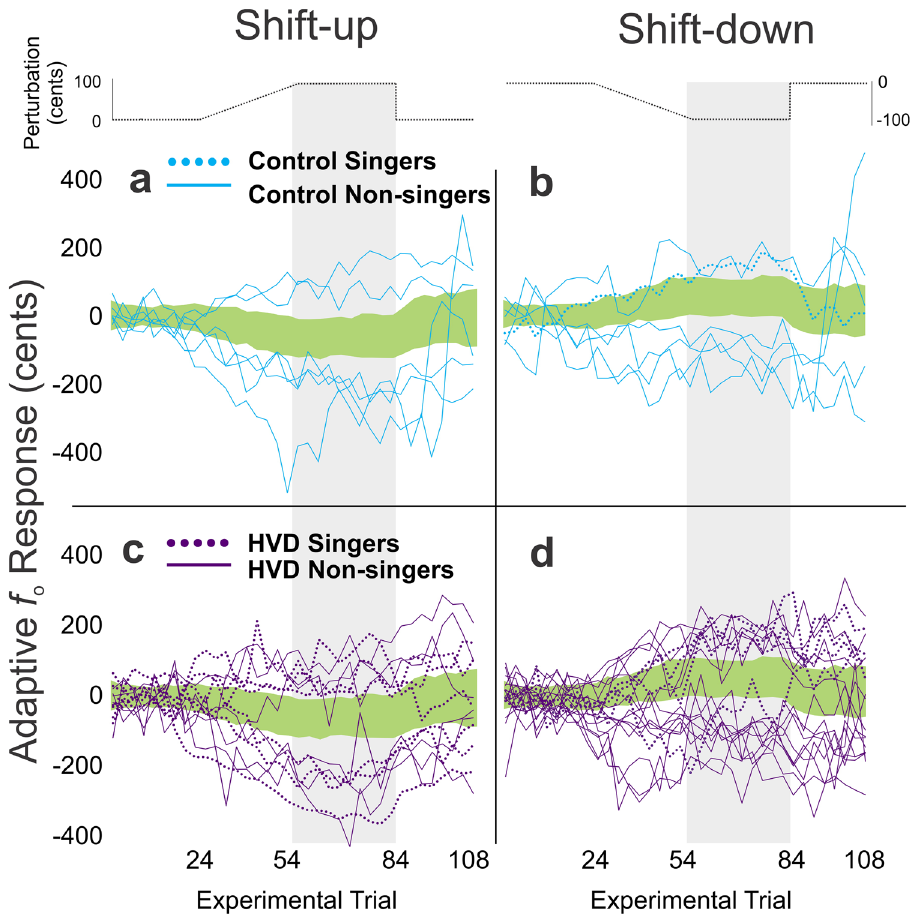
Figure 3. Adaptive responses. Atypical adaptive responses to voice fundamental frequency ( f o ) in cents are shown for the control (light blue) and HVD (dark purple) groups. The atypical responses are plotted for the shift-up (panel a and c ) and shift-down (panel b and d ) conditions for non-singers (solid lines) and singers (dotted lines). The green shaded region in each panel indicates the average of all responses classified as typical + / − standard deviation for both groups. The grey highlighted columns show the hold phase trials used for classification